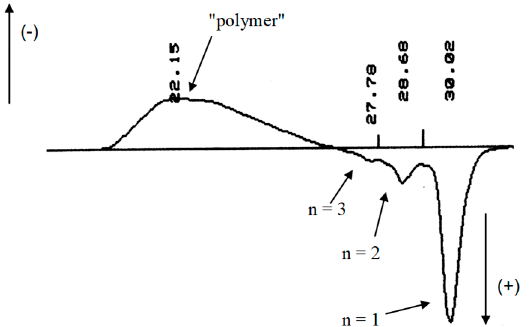
Figure 5. SEC chromatogram (in DMF, with a refractive index detector) of the acetylated telomers mixture obtained by telomerisation of VDF with 2-mercaptoethanol (using di-t-butyl peroxide as the initiator, R 0 = [CTA] 0 /[VDF] 0 = 0.1, acetonitrile as the solvent, at 140 °C, reaction times: 5 h).